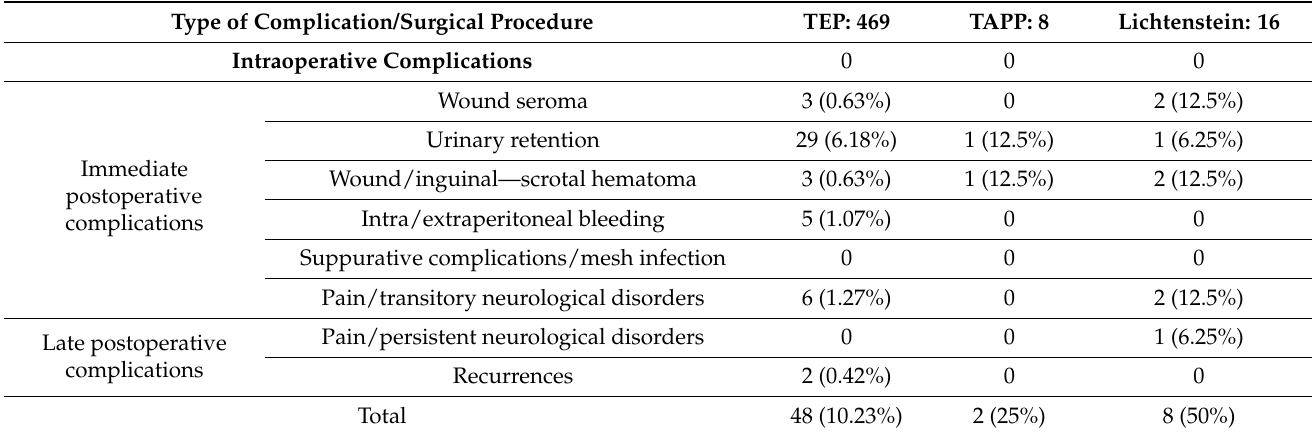
Table 7. Perioperative complications according to the surgical